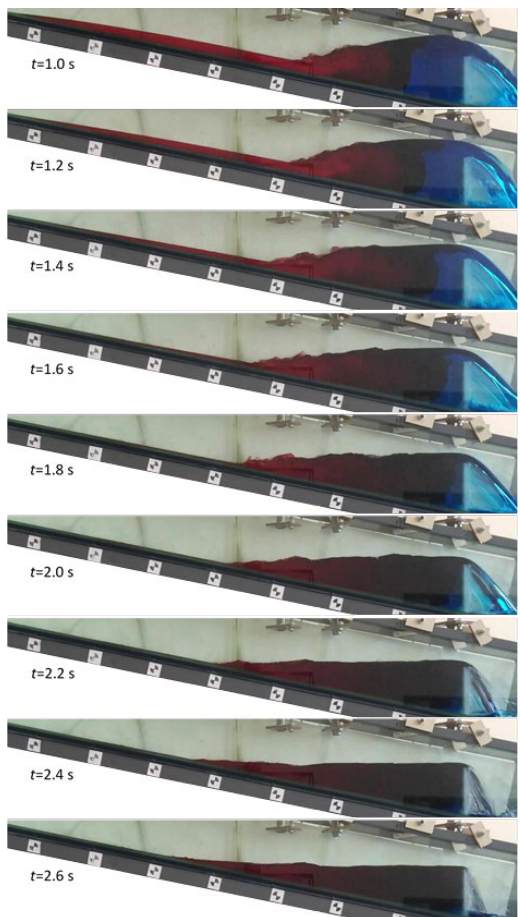
Figure 7. The reflected waves from the downstream dam.